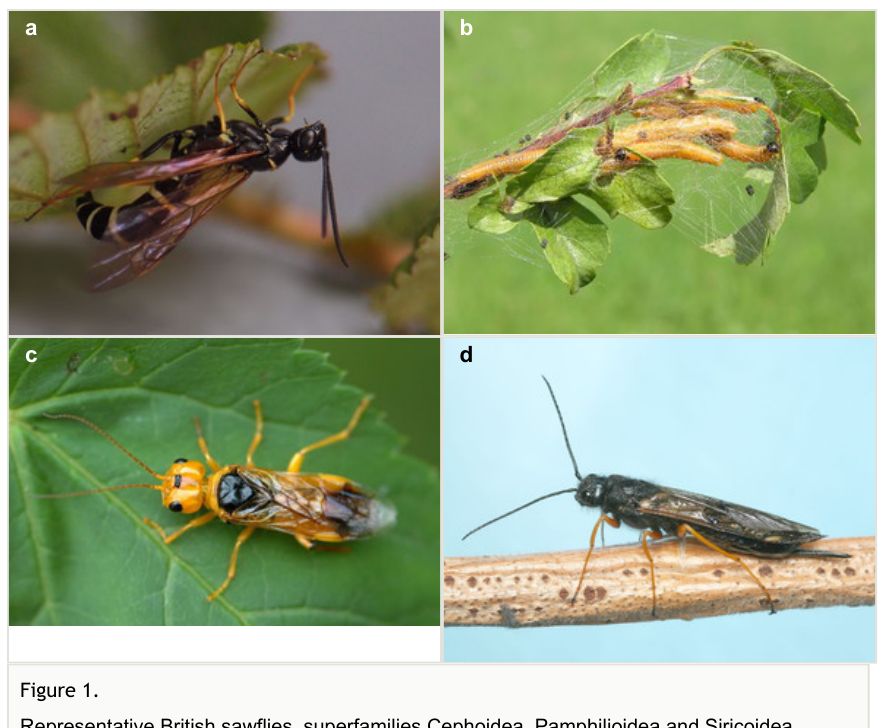
Figure 1. Representative British sawflies, superfamilies Cephoidea, Pamphilioidea and Siricoidea. a : Cephidae, Phylloecus xanthostoma (G.